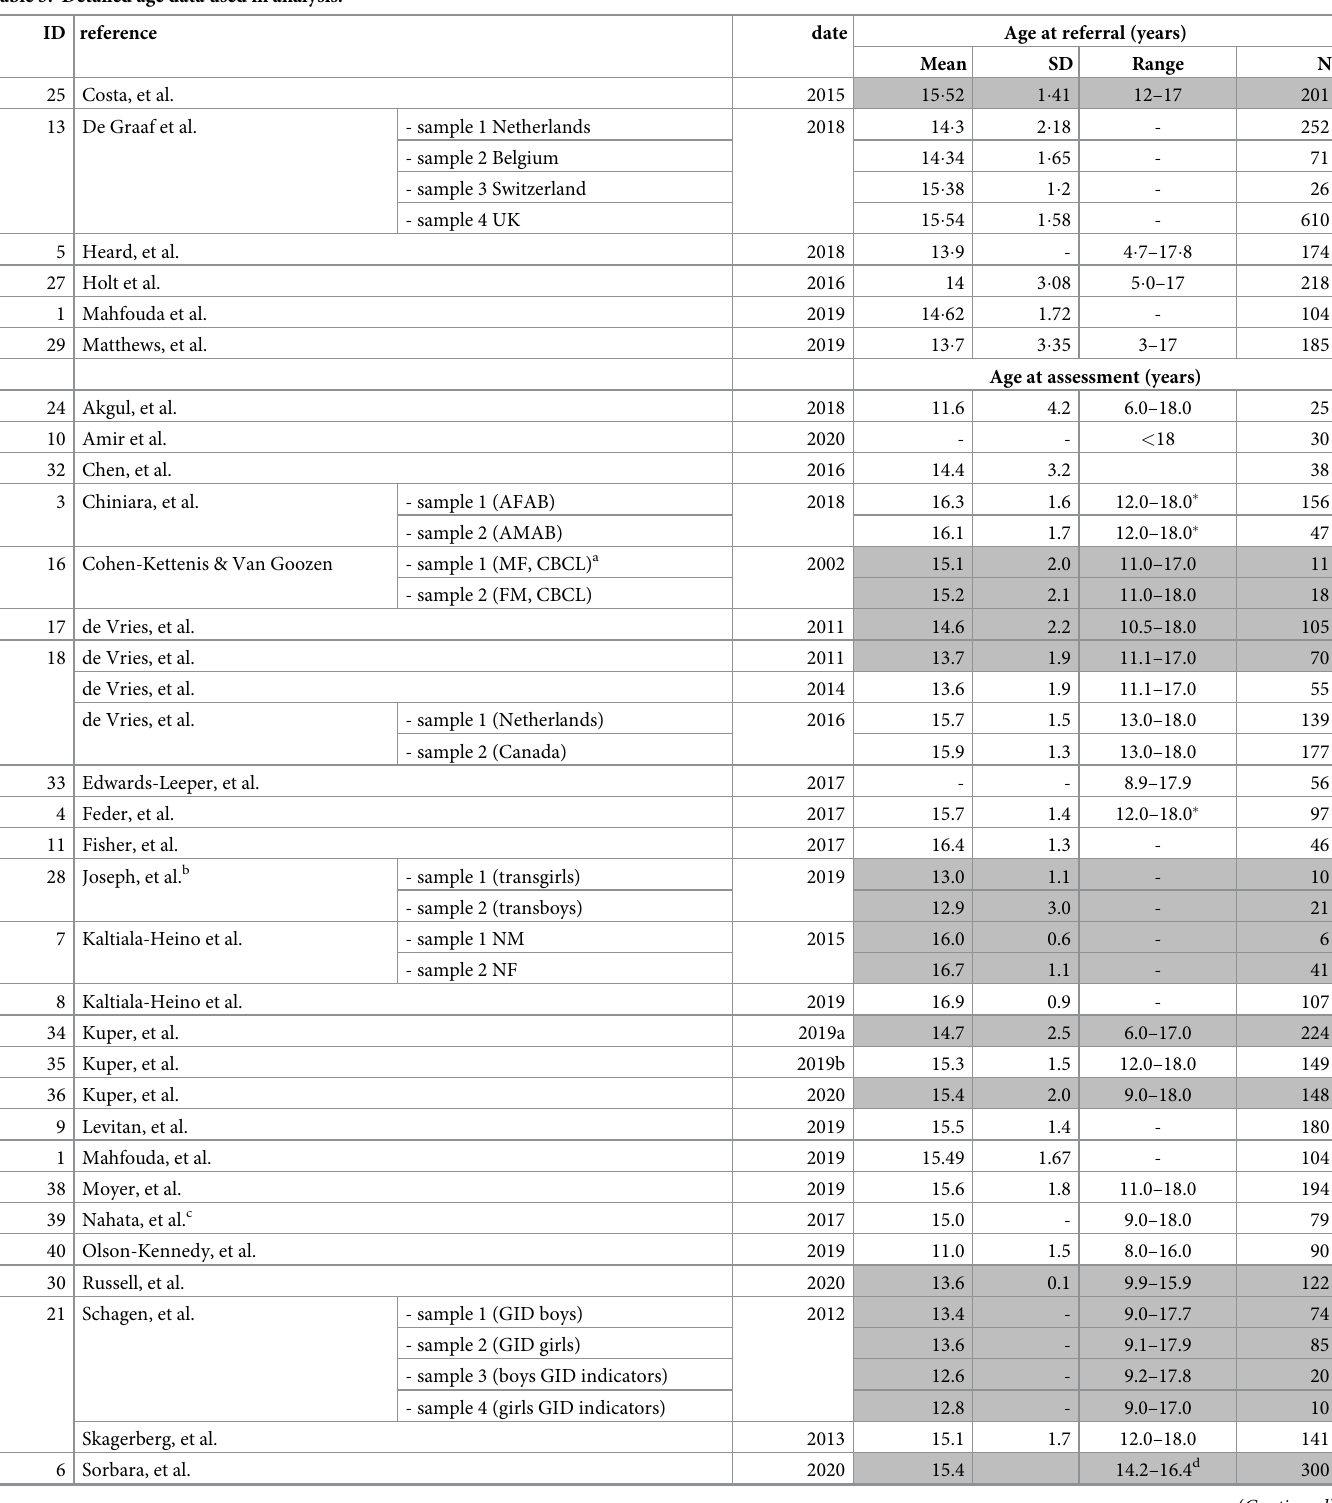
Table 3. Detailed age data used in